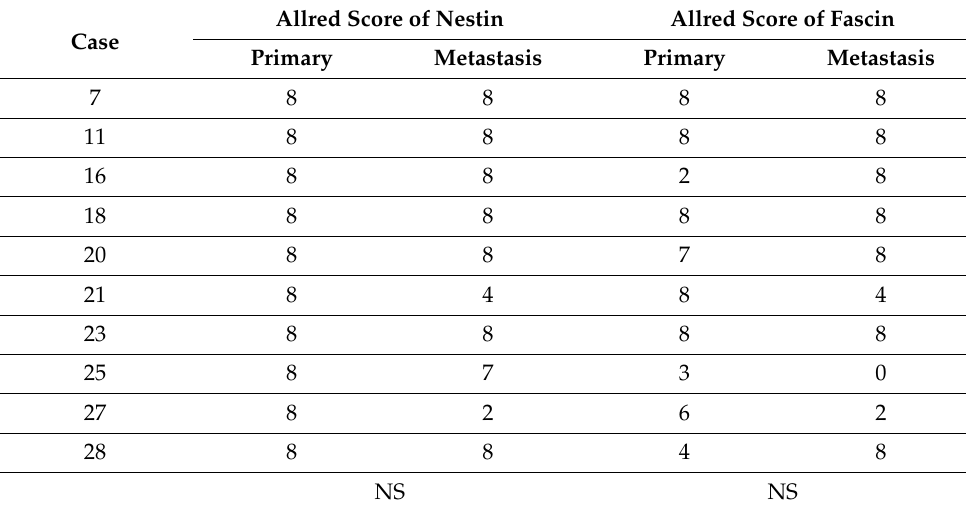
Table 4. The results of immunohistochemical staining of Nestin and Fascin.